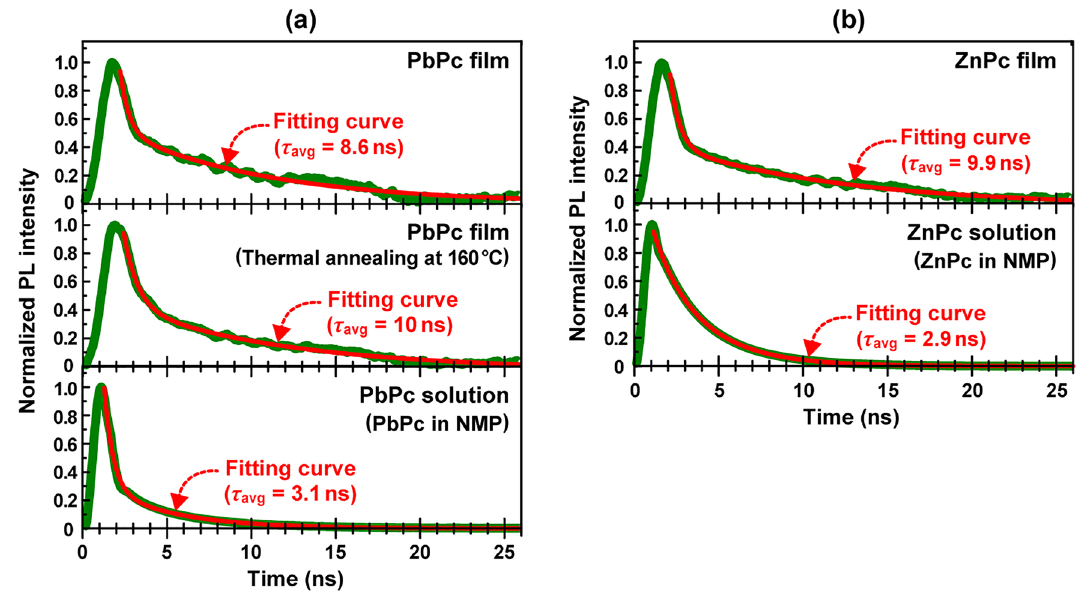
Figure 7. TR-PL spectra of ( a ) 40 nm-thick pristine (top) and postannealed (middle) PbPc films along with isolated PbPc molecules in NMP (bottom) and of ( b ) 40 nm-thick ZnPc film (top) and isolated ZnPc molecules in NMP (bottom). The method to estimate the average lifetime ( t avg ) from TR-PL spectra was described elsewhere 22 . Thermal annealing was performed at 160 °C for 1